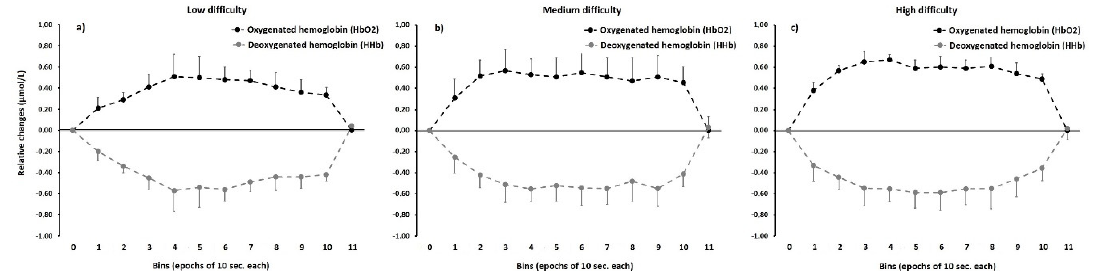
Figure 2. Example of the relative changes in oxygenated hemoglobin and deoxygenated hemoglobin in one participant during the three experimental tasks. Bin 0 marks the baseline and Bin 11 the end of each task. The relative changes were computed as the mean change in the overall optodes. ( a ) panel—low level problem (L); ( b ) panel—medium level problem (M); ( c ) panel—high level problem